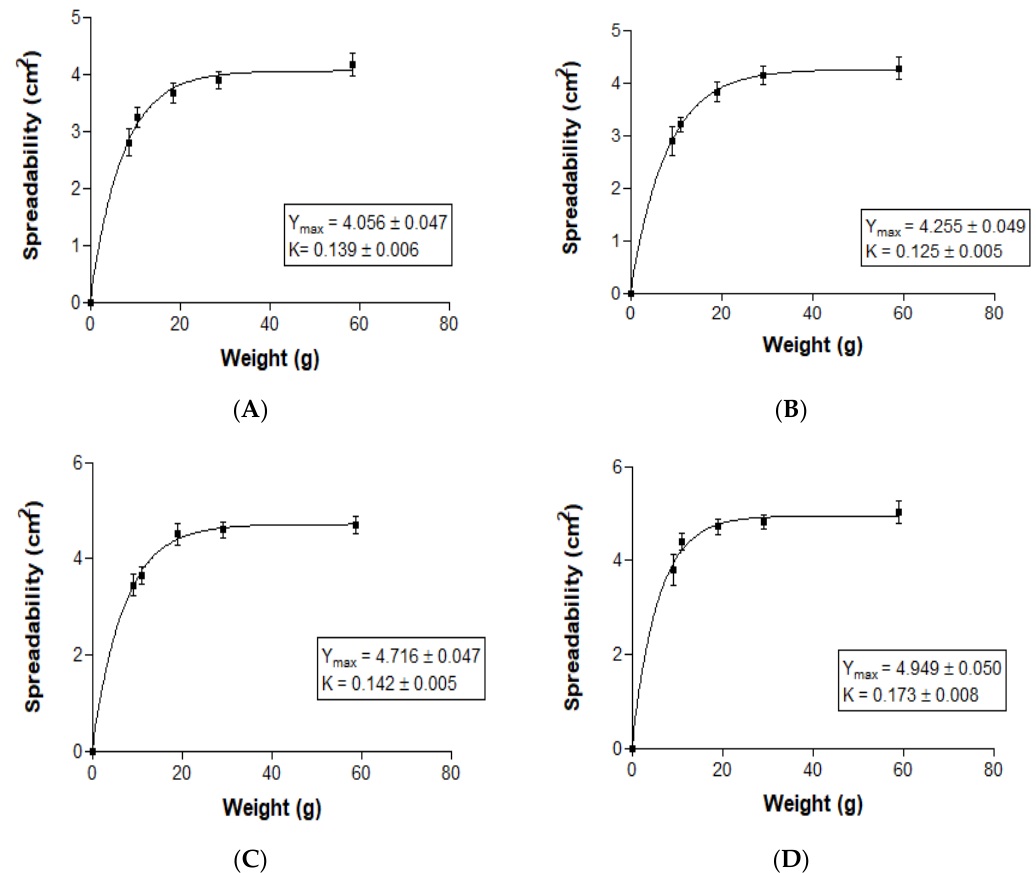
Figure 4. Spreadability of NLCs-F3 ( A ); NLCs-F3-L ( B ); NLCs-F9 ( C ); and NLCs-F9-L ( D ).